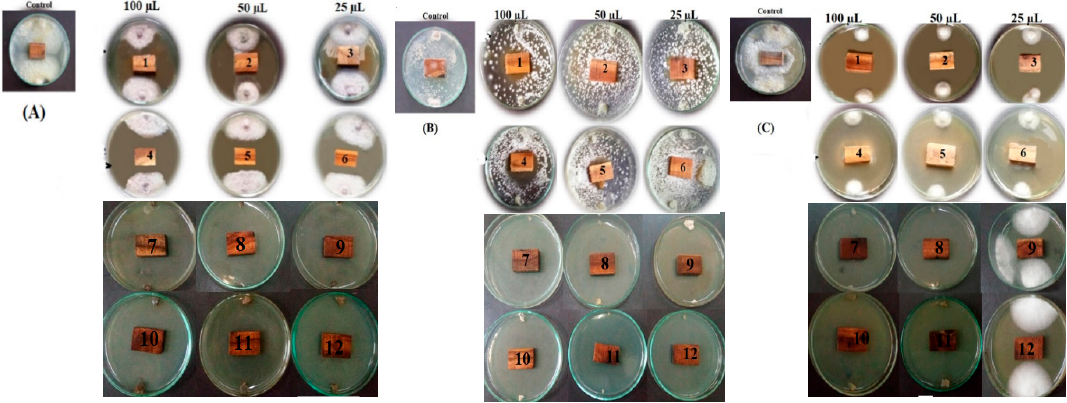
Figure 6. In vitro antifungal bioassay of treated-wood with (1,2,3) C. citriodora leaf recovered oil; (4,5,6) C. citriodora fruit recovered oil; (7,8,9) C. citriodora leaf essential oil and (10,11,12) C. citriodora fruit